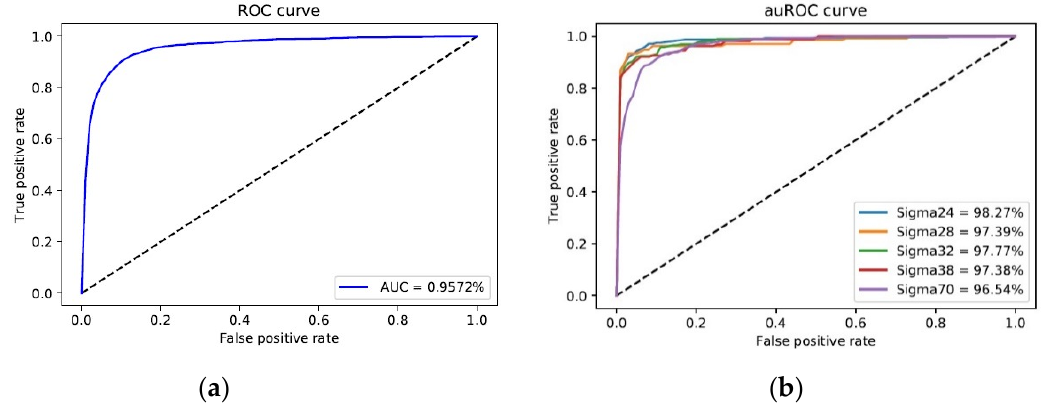
Figure 4. Receiver operating characteristic (ROC) curves. ( a ) Promoter non-promoter ROC curve. ( b ) Sigma subclasses ROC curve.